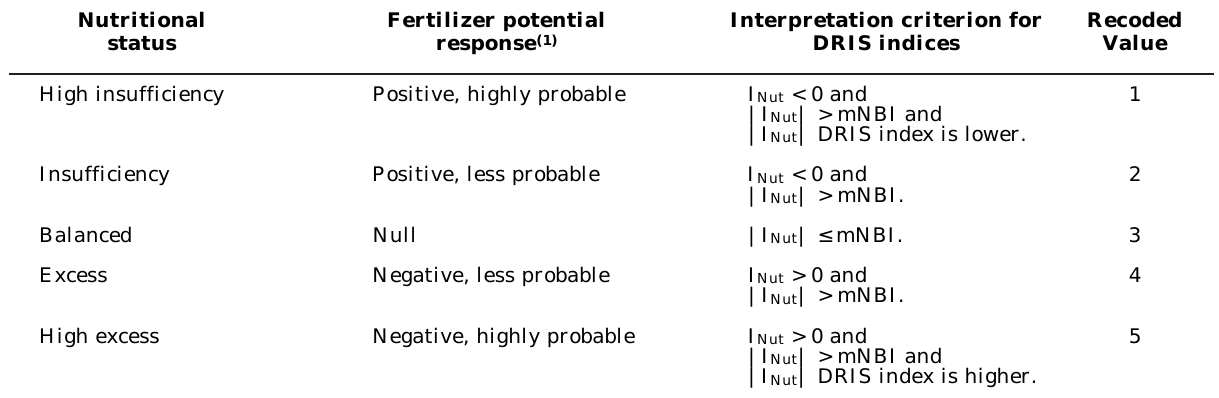
(1) A positive response implies that nutrient addition increased plant growth rate and a negative response implies that the nutrient addition decreased plant growth rate (Wadt,